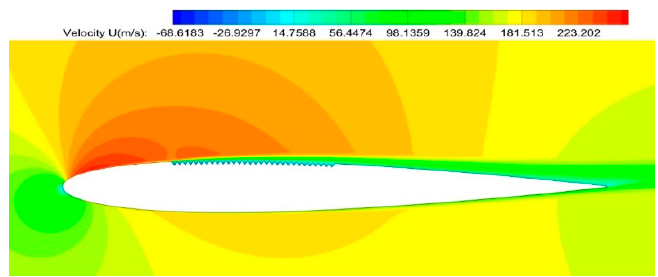
Figure 12. 4° angle of attack, speed distribution of grooves on the suction side.